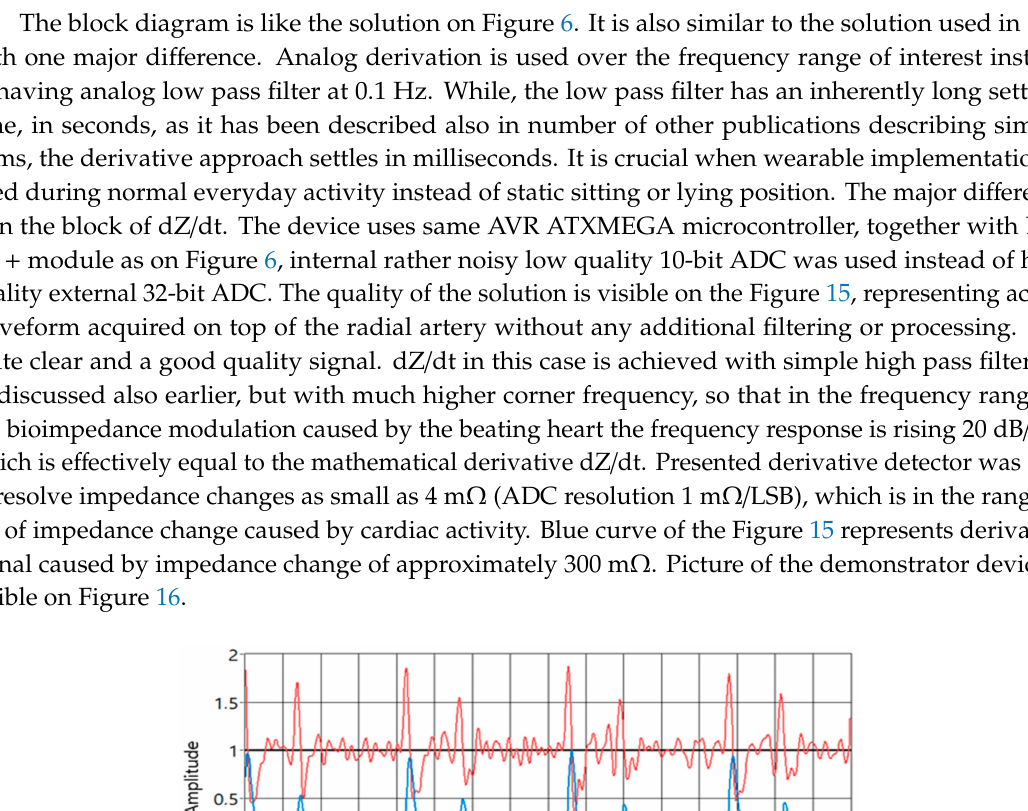
Figure 14. Simplified schematic of the EBI measurement device using filtering for derivation.